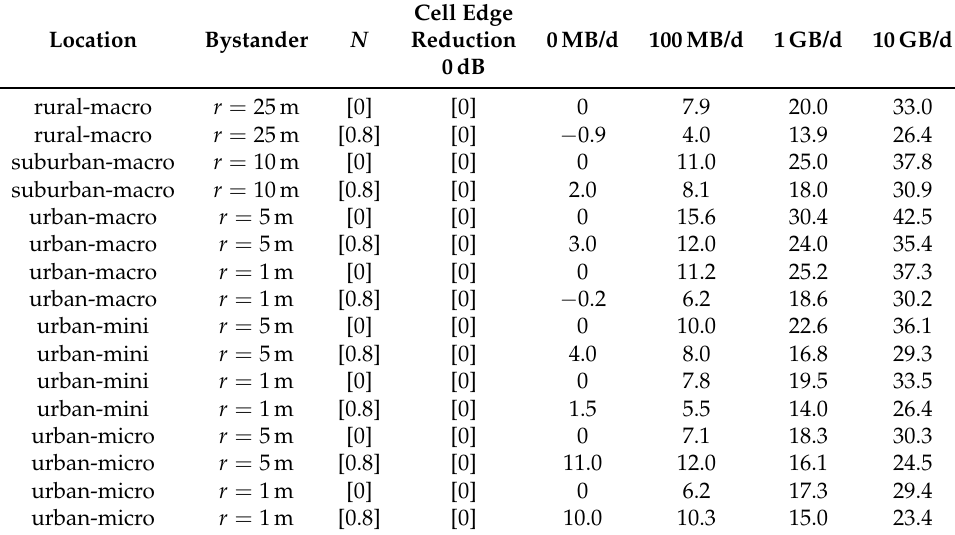
Table 4. Total dose change (in dB) as a function of the data usage relative to the non-user without indoor coverage (i.e., values for N =80% have been normalized to the scenario for N = 0 with no data usage). Displayed are the 95th percentile values for all four user types (light user (100MByte/day), moderate user (1GByte/day), heavy user (10GByte/day), and non-user (0MByte/day)). Situations have been analyzed for N = 0 (i.e., no additional indoor coverage) and N = 80%, i.e., rather strong indoor